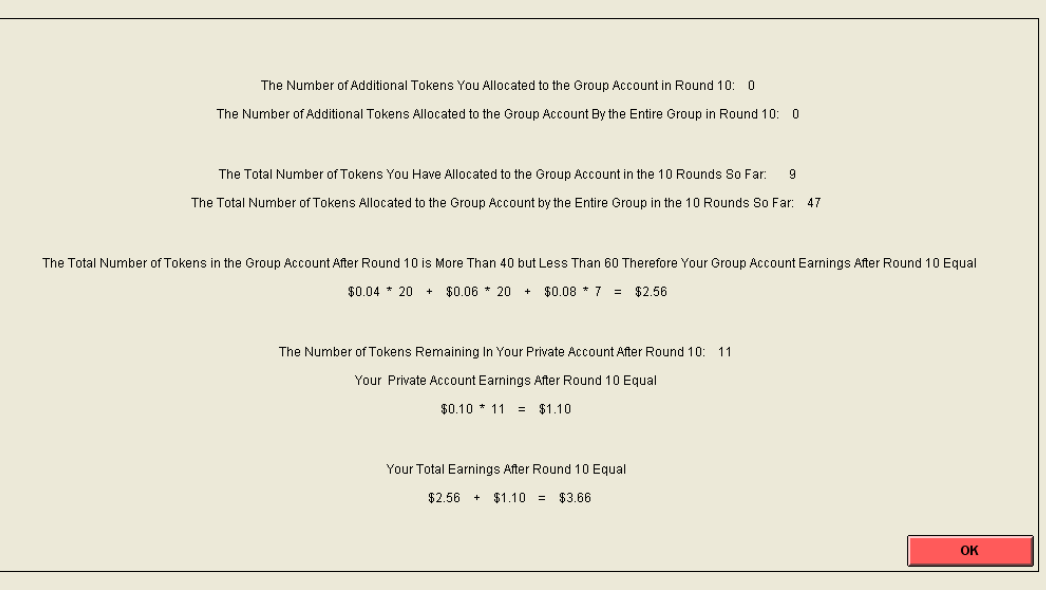
Figure A4: End of Sequence Screen.